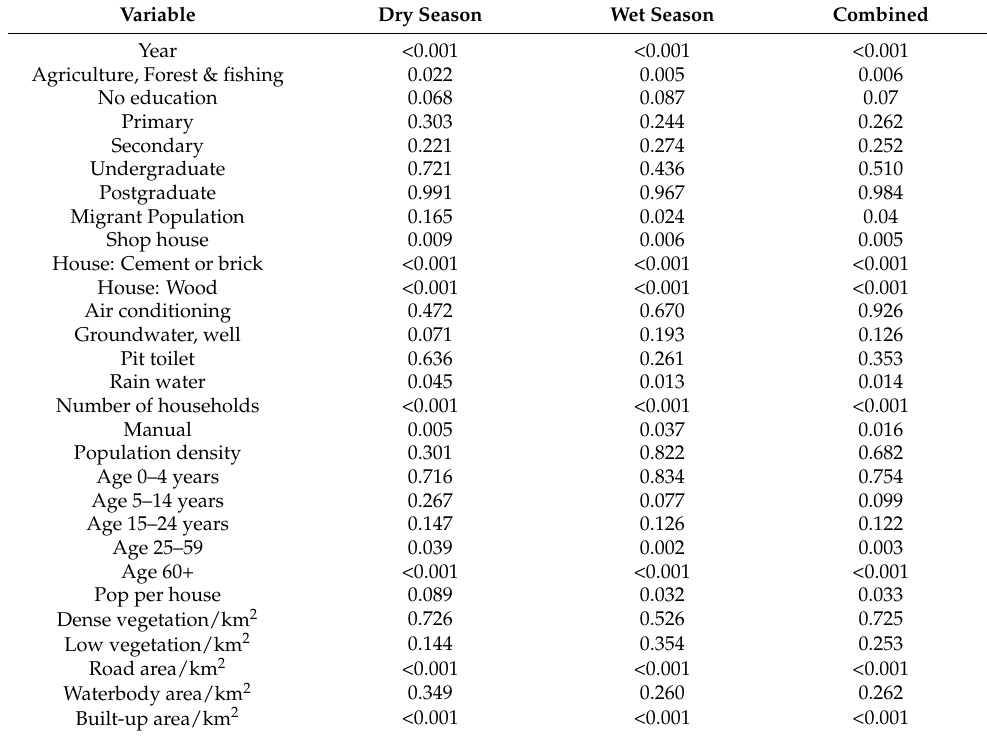
value for subsequent selection for multivariable